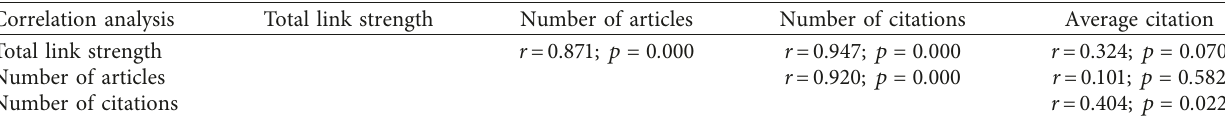
Table 7: Pearson correlation analysis among parameters related to countries/regions’ impacts on PPP